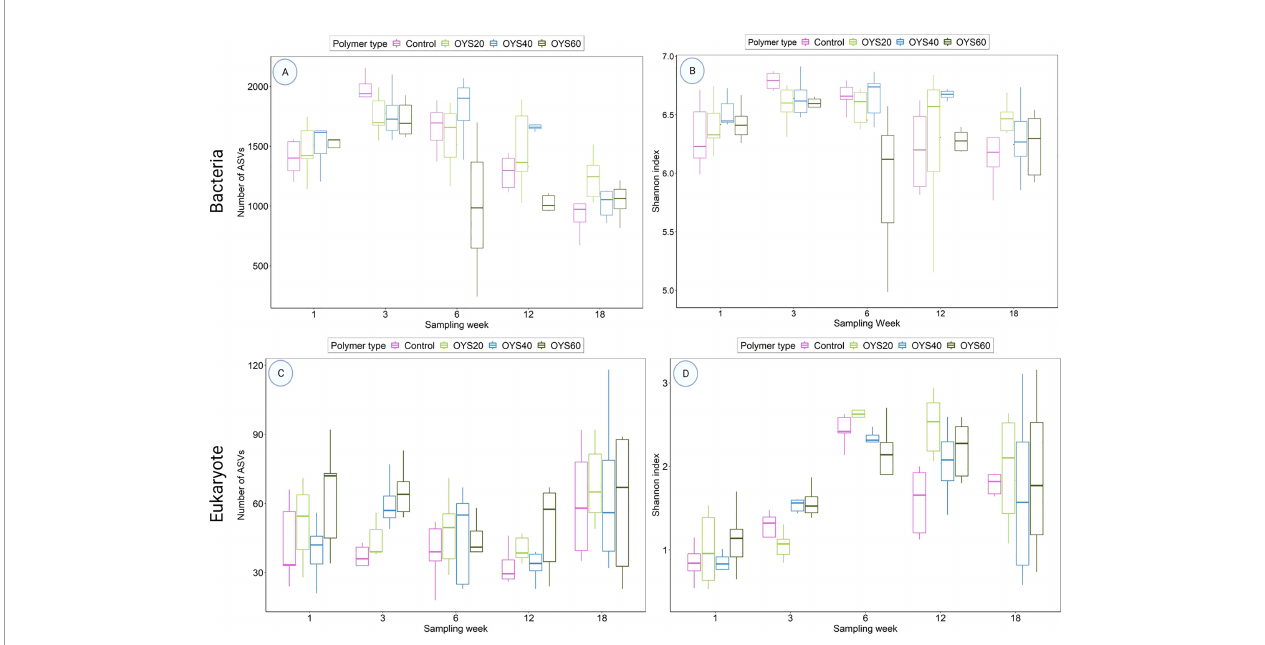
FIGURE 2 | Boxplots of Amplicon Sequence Variants (ASVs) number (A, C) and Shannon index (B, D) comparing bio-polymers and control between sampling times in bacterial (top) and eukaryote (bottom) datasets. The boxes denote interquartile range (IQR), with the median as a black line and whiskers extending the most data extreme